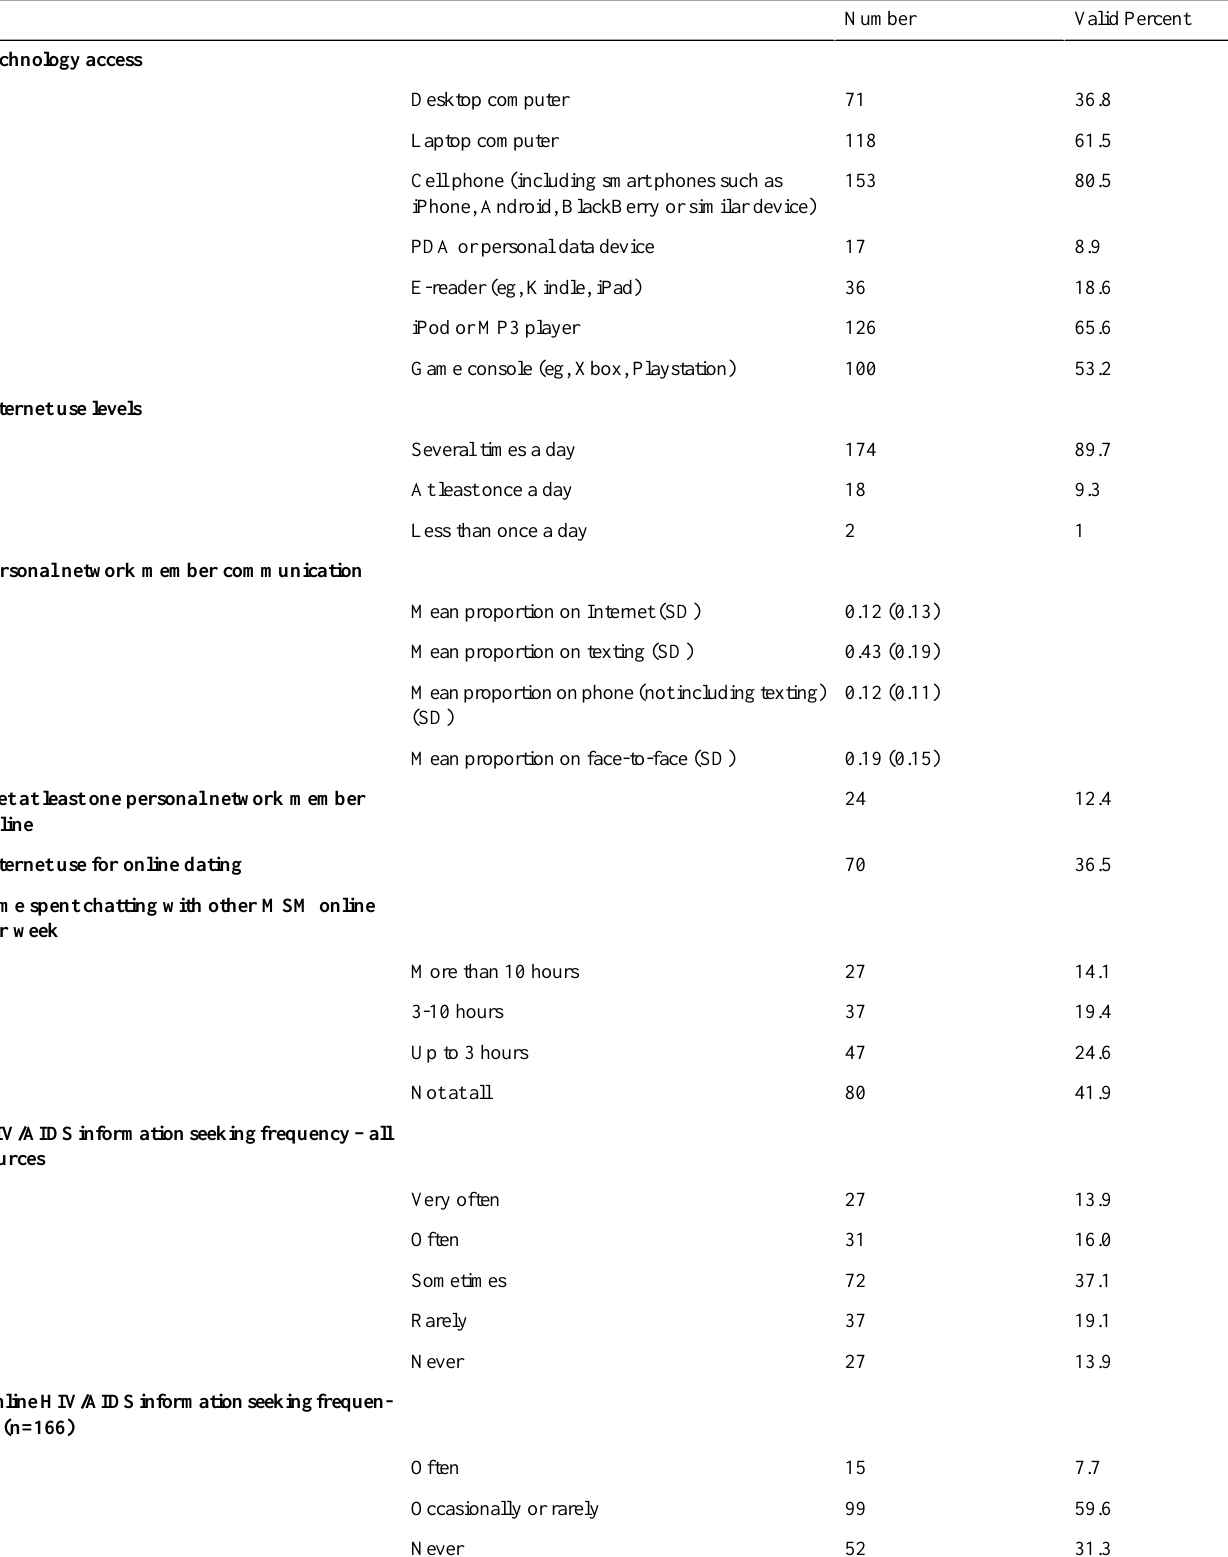
Table 2. Survey participants’technology use and information interaction